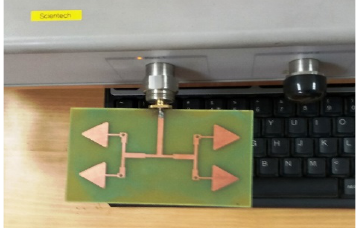
Figure 13:S11 measurement of 2×2